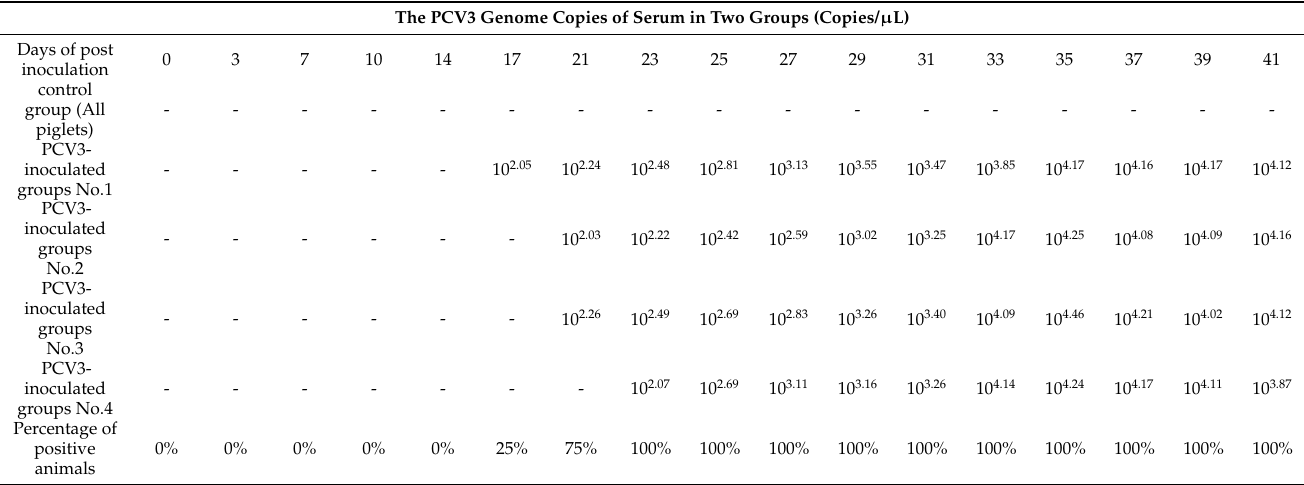
Table 1. Results of PCV3 detection by qRT-PCR in serum by PCV3 pigs. The PCV3 Genome Copies of Serum in Two Groups (Copies/ µ